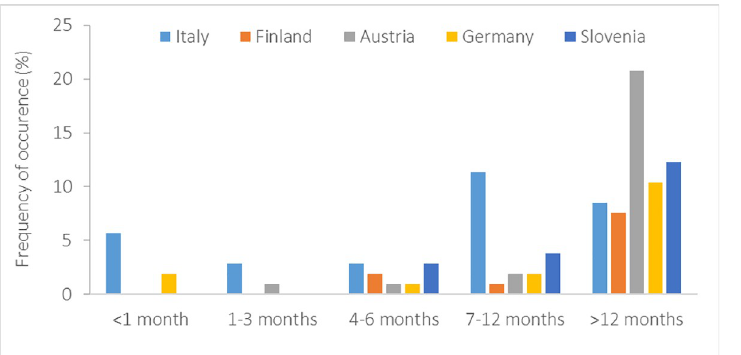
Fig 7. Duration of relocation of migrating student-athletes.